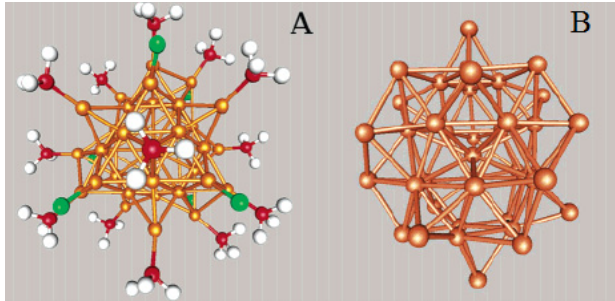
cluster; and ( B ) Au core of Au 39